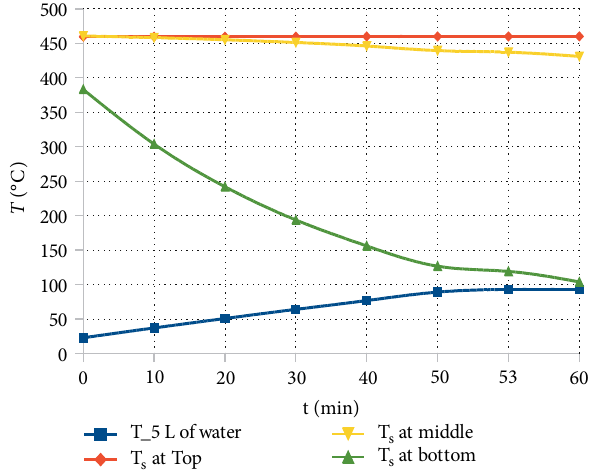
Figure 16: Temperature of storage versus temperature of water during boiling of 5 liters of water with 0.0048 kg/s mass flow rate for the maximum direct normal irradiance.